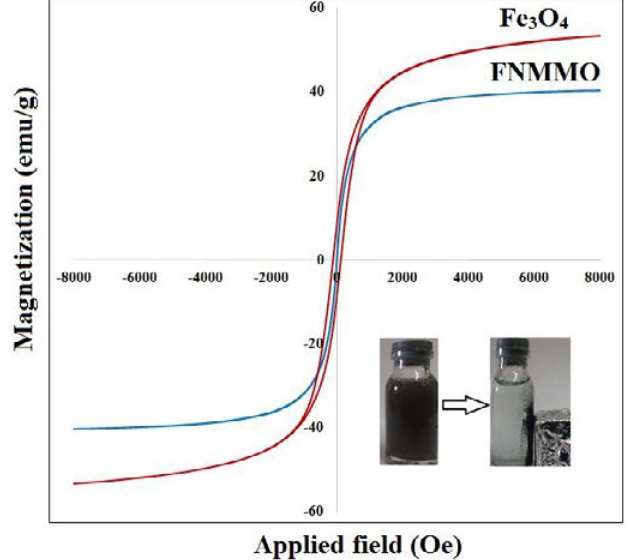
Fig. 5. The magnetic properties of pure Fe